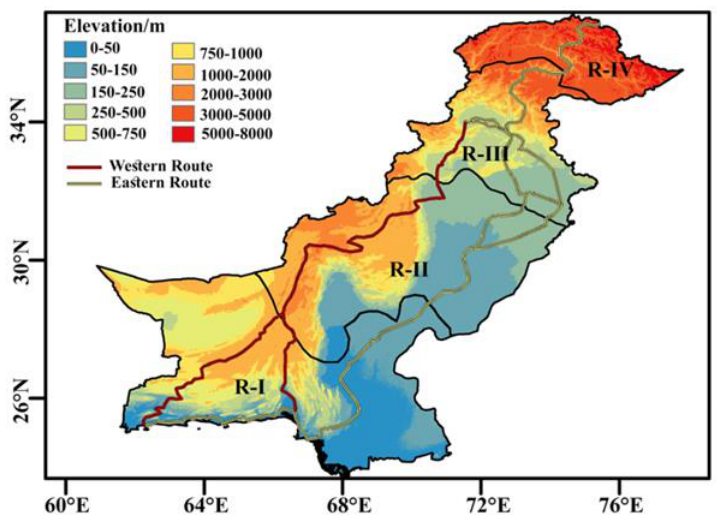
Figure 1. Location of the China–Pakistan Economic corridor routes and different climate regions. The black color lines demarcate hyper-arid, arid, humid, and glacial regions named R-I, R-II, R-III, and R-IV, respectively.